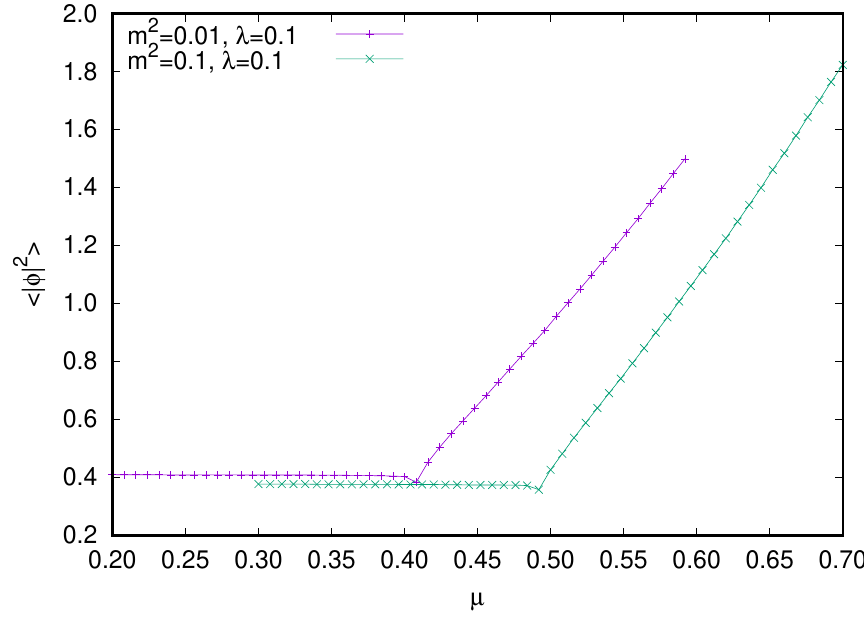
Figure 8 . hj (cid:30) j 2 i as a function of (cid:22) at K = 64 and D = 64 on V = 1024 2 . The Silver Blaze phenomenon is observed irrespective of the values of the physical parameters.